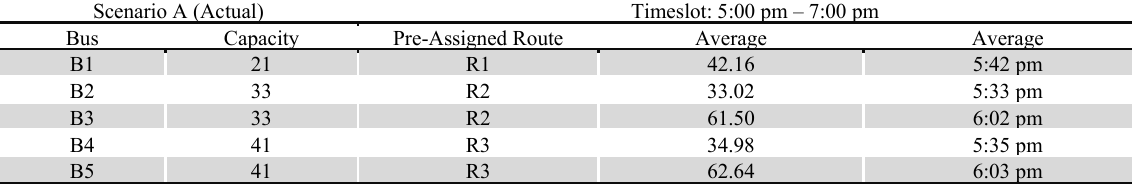
Results for the simulation of the actual situation